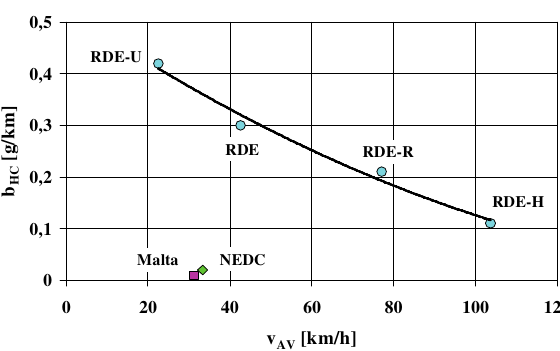
Fig. 17. The relation between the mean road emission of hydrocarbons – b HC and the mean vehicle speed – v AV in each test cycle